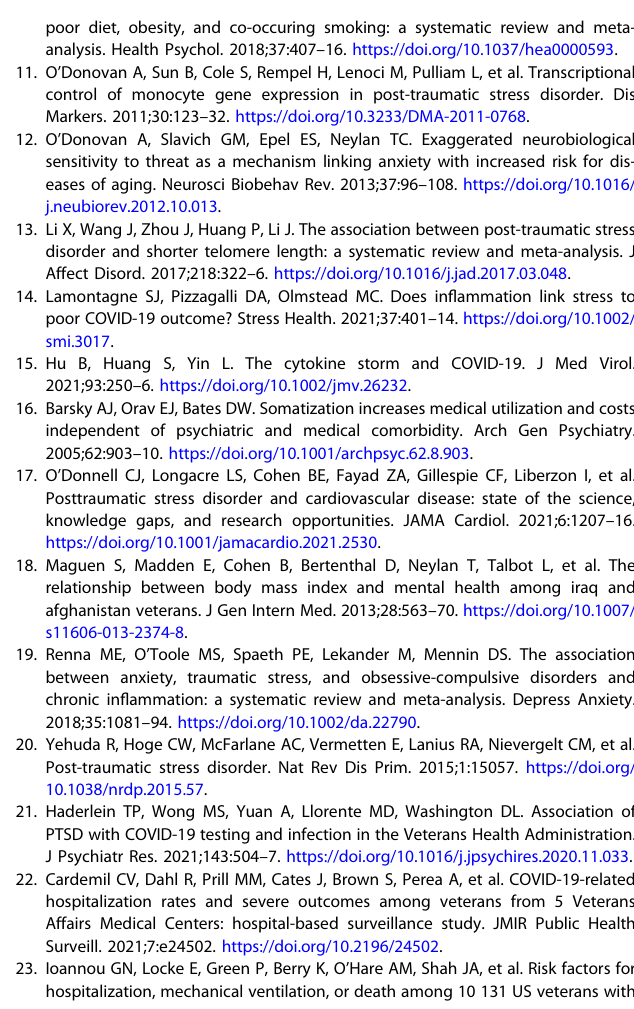
Fig. 1 Relative risks of 60-day hospitalizations and deaths following COVID-19 infection for individual psychiatric disorders. RR relative risk, CI con fi dence intervals, PTSD post-traumatic stress disorder. Reference group for each model is No Psychiatric Disorders ( n = 105,405 (46.2%)); each individual psychiatric disorder was estimated in a separate model as the primary predictor and adjusted for age, age squared, sex, race, and